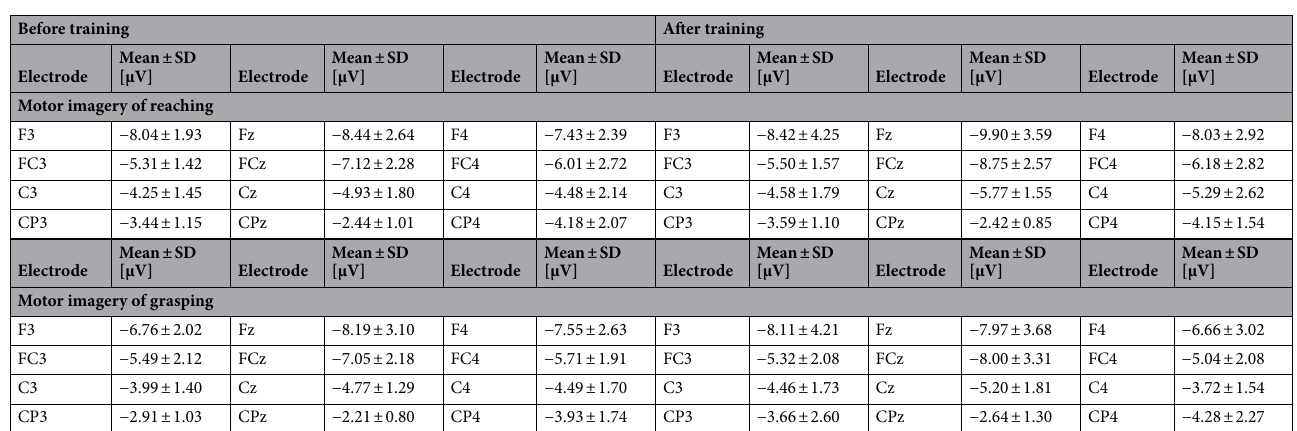
Table 1. Mean value with standard deviation of ERP amplitude [µV] for motor imagery of reaching and motor imagery of grasping before and after 4 weeks of motor imagery training. Notice that the spatial arrangement of the electrodes in the table corresponds to the International 10–10